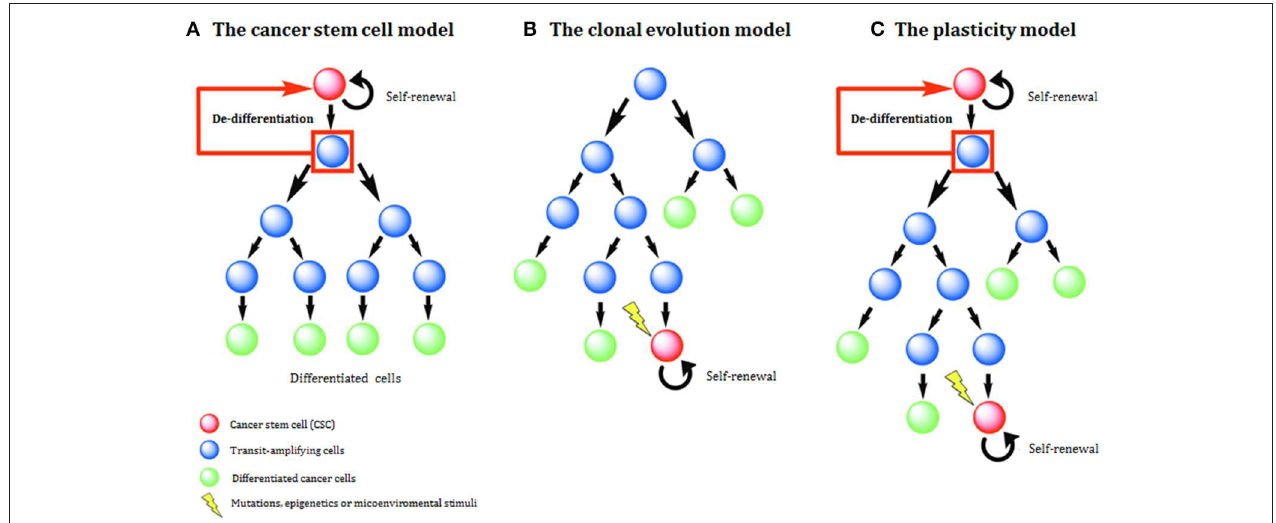
FIGURE 1 | Models of tumor development and heterogeneity. (A) The cancer stem cell (CSC) model of tumor development. Genetic or epigenetic mutations activate stem-like programs in a single cell, generating a CSC. This CSC is able to indefinite self-renewal and/or differentiation and all derived tumor cells have a hierarchical inheritance pattern. (B) The clonal evolution (CE) model of tumor development. Due to the acquisition of epigenetic and genetic mutations through time, any cell might have tumorigenic potential. Tumor heterogeneity is due to the propagation of cells carrying genetic mutations. (C) The plasticity model highlights the plastic state of cancer stemness. Based on the model, differentiated non-tumorigenic cancer cells can potentially revert back to CSCs.